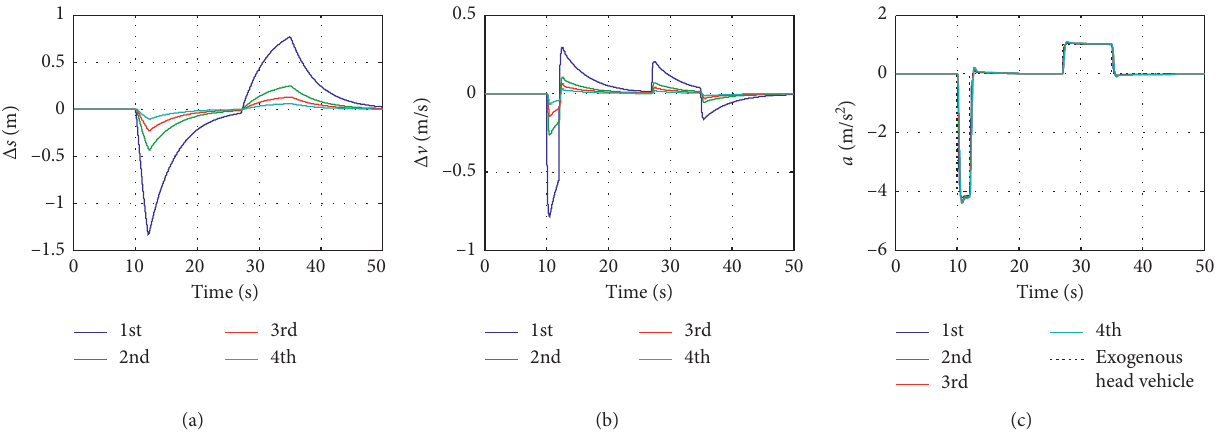
Figure 7: Simulation result of CSG-IPSO: (a) gap error, (b) relative speed, and (c) actual